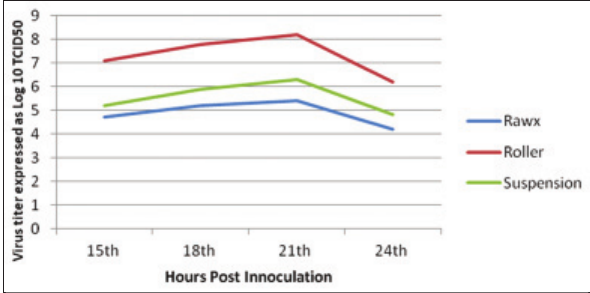
Figure-2: Effect of different cell culture systems on foot and mouth disease virus serotype (O) infectivity in baby hamster kidney-21 cell line at 37°C.